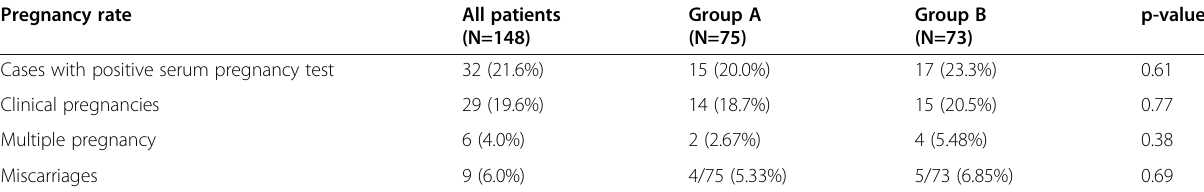
Table 3 The secondary